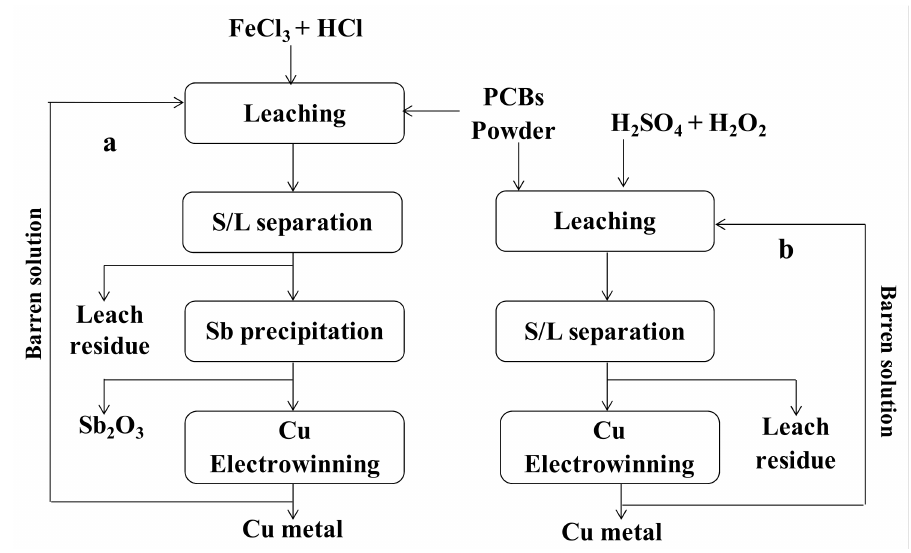
Figure 1. Cu metal recovery from waste PCBs. The flow sheet is drawn following information collected from ( a ) [31], ( b ) redrawn following